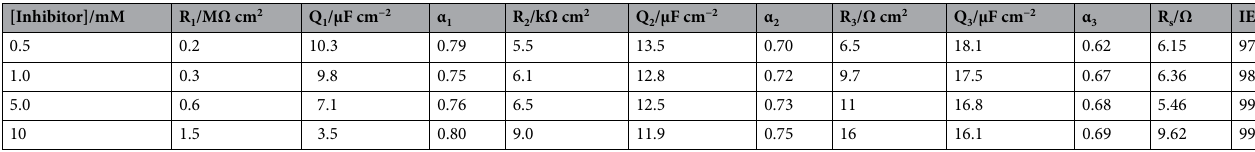
Table 6. Impedance parameters of Mo electrode as a function of inhibitor concentration in 3.0 M phosphoric acid containing 1.0 M NaCl at 298